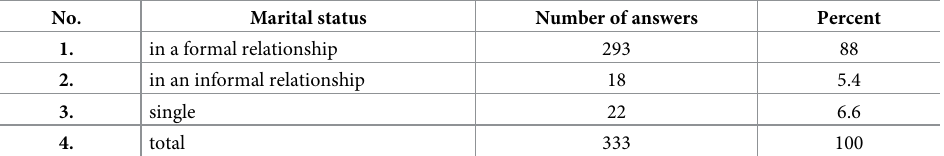
Table 4. Characteristics of the surveyed women by marital status. N = 333 (one woman did not answer the ques- tion). Source: Study by Ewa Krause. No.